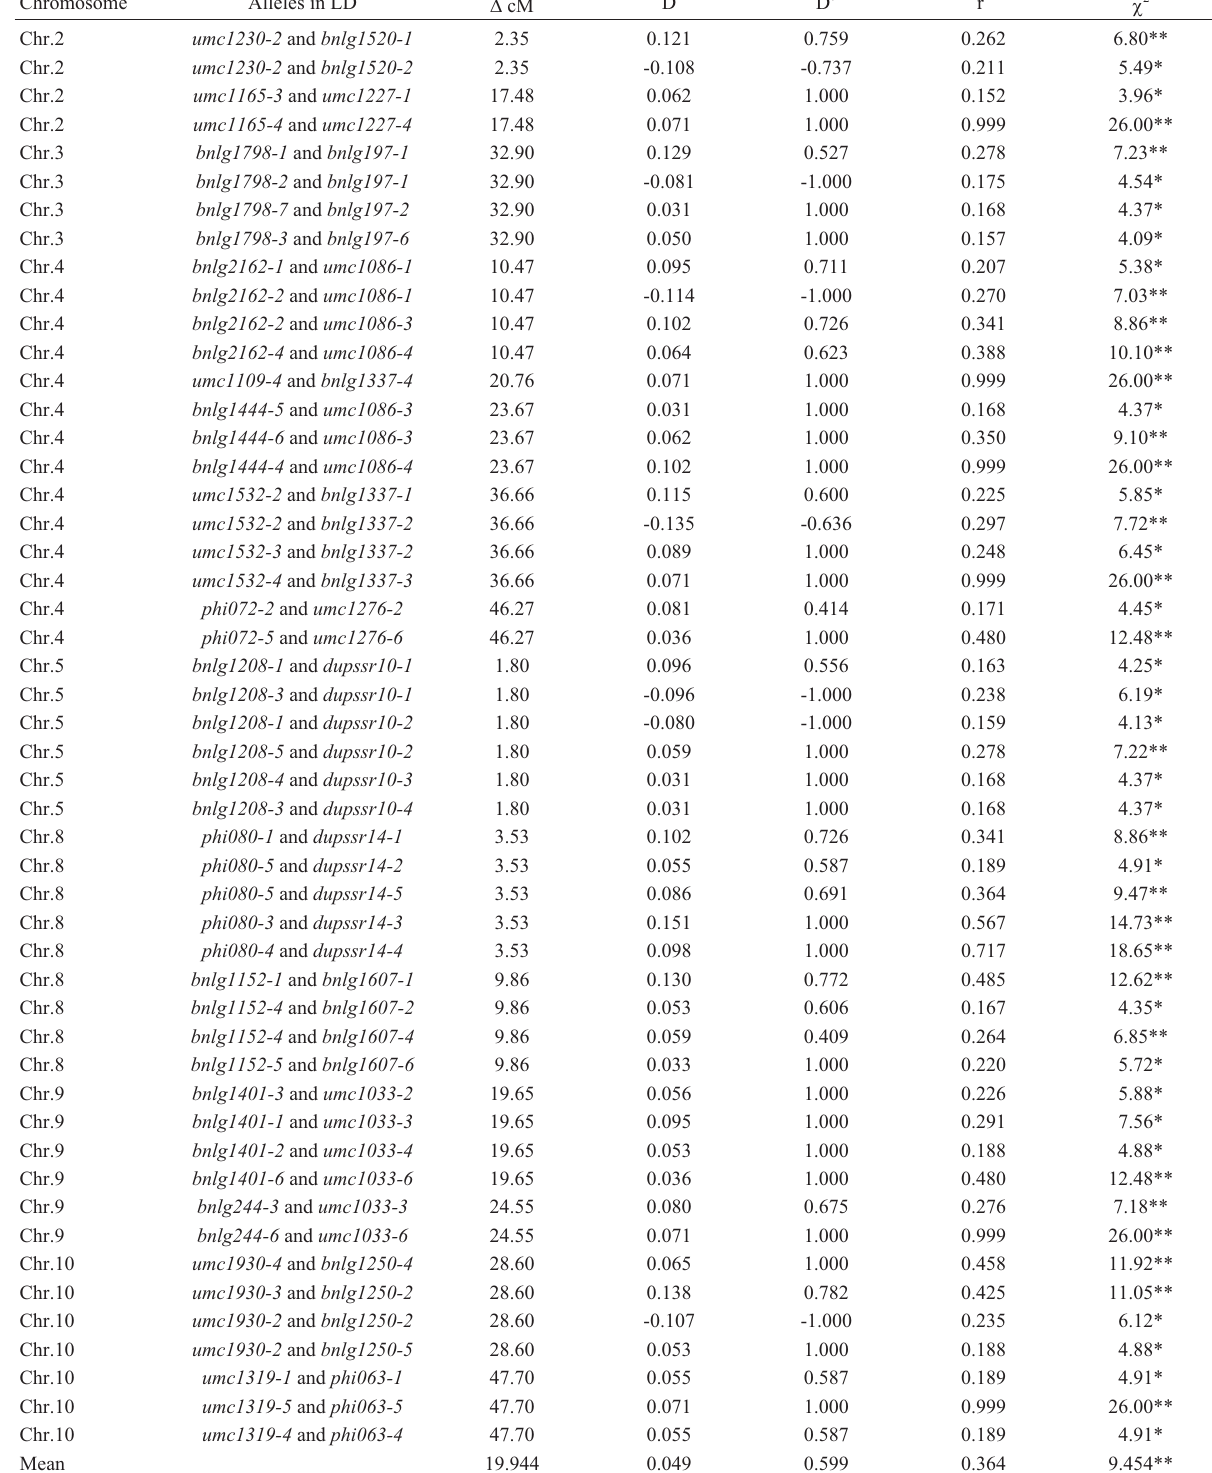
Table 2 - Pairs of alleles in linkage disequilibrium from different loci less than 50 cM apart, on the same